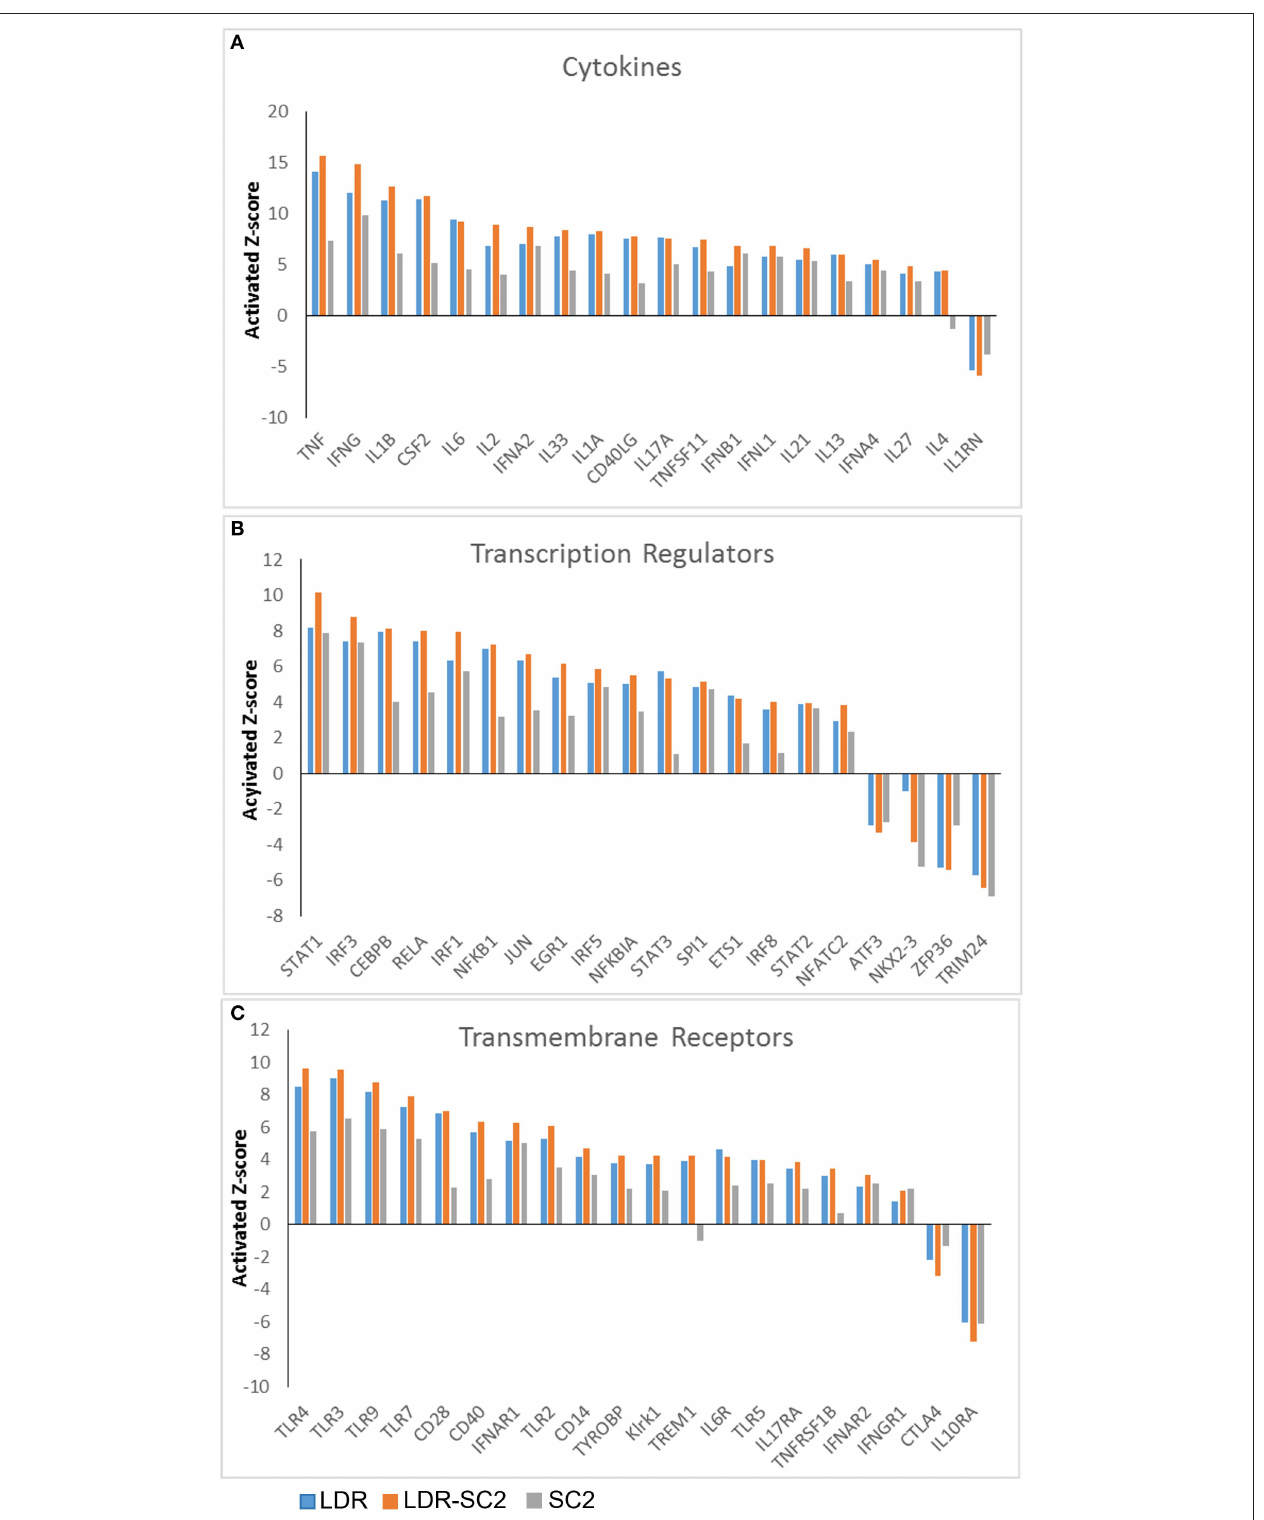
FIGURE 5 | Analysis of upstream regulators. The Ingenuity pathway analysis revealed upstream regulators responsible for gene expression changes in the LDR-SC2 group com-pared to the LDR and SC2 groups presented by their activated Z-score value. Thresh-old was defined as p < 0.05 and − 2 ≥ Z-score or Z-score > 2 in the RS group. (A) cytokines. (B) transcription regulators. (C) transmembrane receptors.